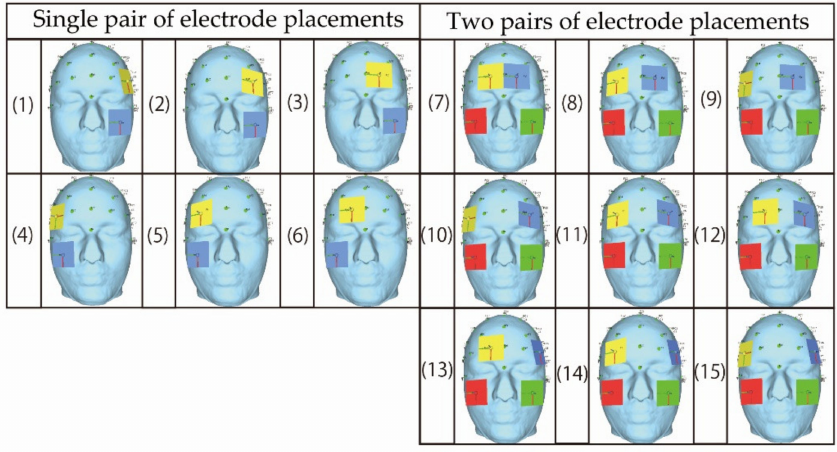
Figure 2. The electrodes’ placement that is gradually separated from each other.